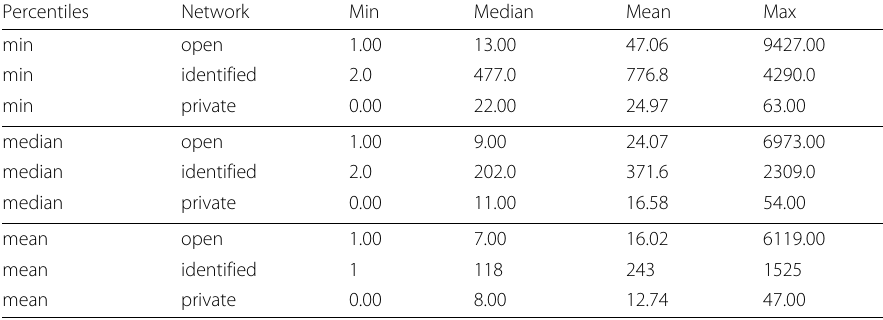
Table 20 Degree distributions of the open metabolites networks, the identified nodes in the experimentation and the private networks according to combined score percentiles Percentiles